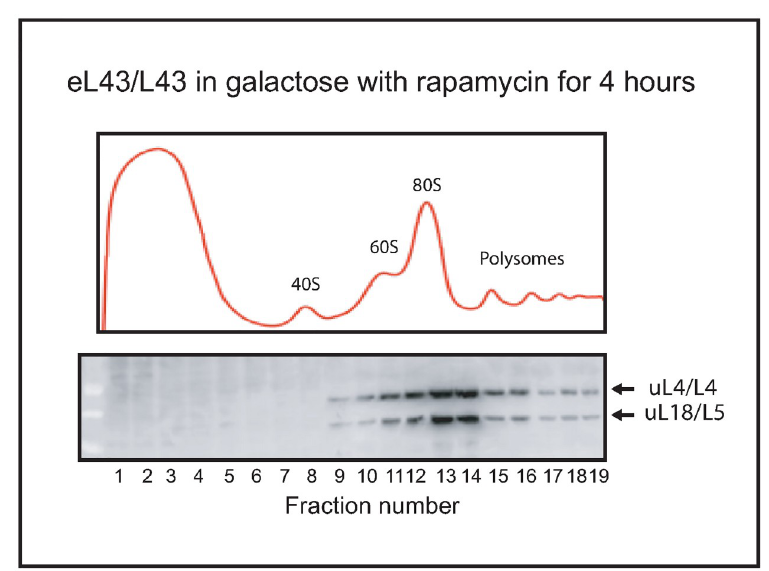
Fig 6. Extra-ribosomal uL18 does not accumulate during degradation of cytoplasmic ribosomes. Rapamycin was added to Pgal-eL43/L43 growing in galactose medium ( no shift to glucose) and 4 hours later an extract was fractionated on a sucrose gradient centrifugation and aliquots of fractions were analyzed on a western blot developed with antisera specific to uL18/L5 and uL4/L4. All fractions from the top through the polysome region of the sucrose gradient are shown.